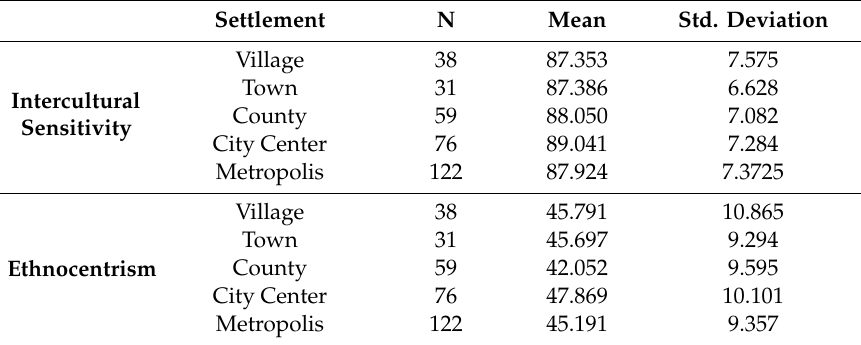
Table 15. Mean and standard deviation of students’ scores by the settlement where they grew up in the Intercultural Sensitivity Scale and the Ethnocentrism Scale. N Mean Std. Deviation